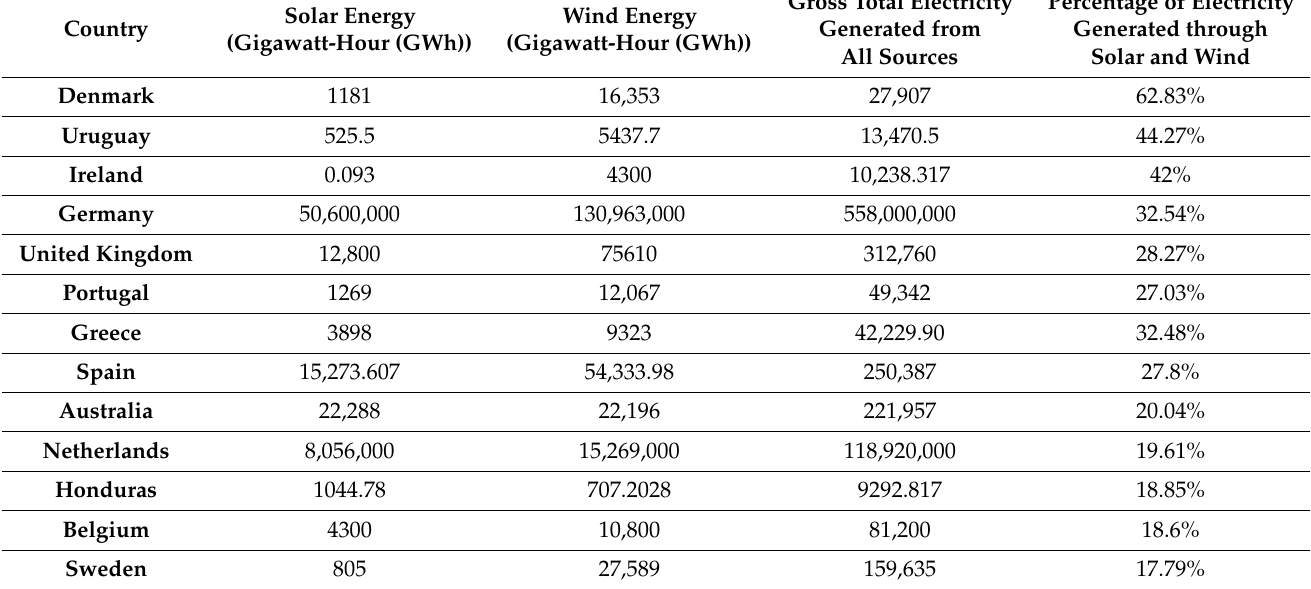
Table 1. Top countries in 2020 with a high share of solar and wind energy in their total electricity generation